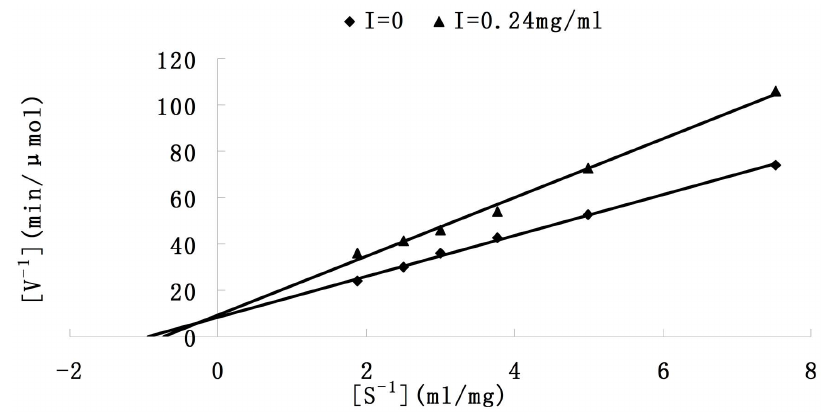
Figure 4. Lineweaver-Burk curve of enzyme reaction rate and the concentration of subtract.